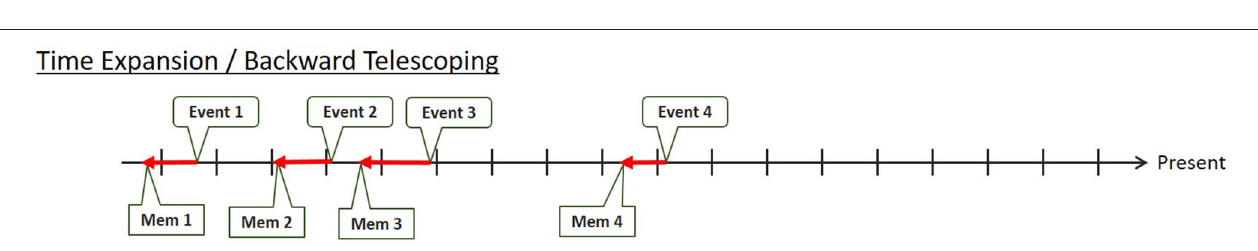
FIGURE 3 | Illustration of Time Expansion due to backward telescoping of events from the remote past. Event-markers (“Event”) illustrate the factual date of an event while memories of these events (“Mem”) might be systematically dated back too far. The time between now and the wrongly remembered date is therefore